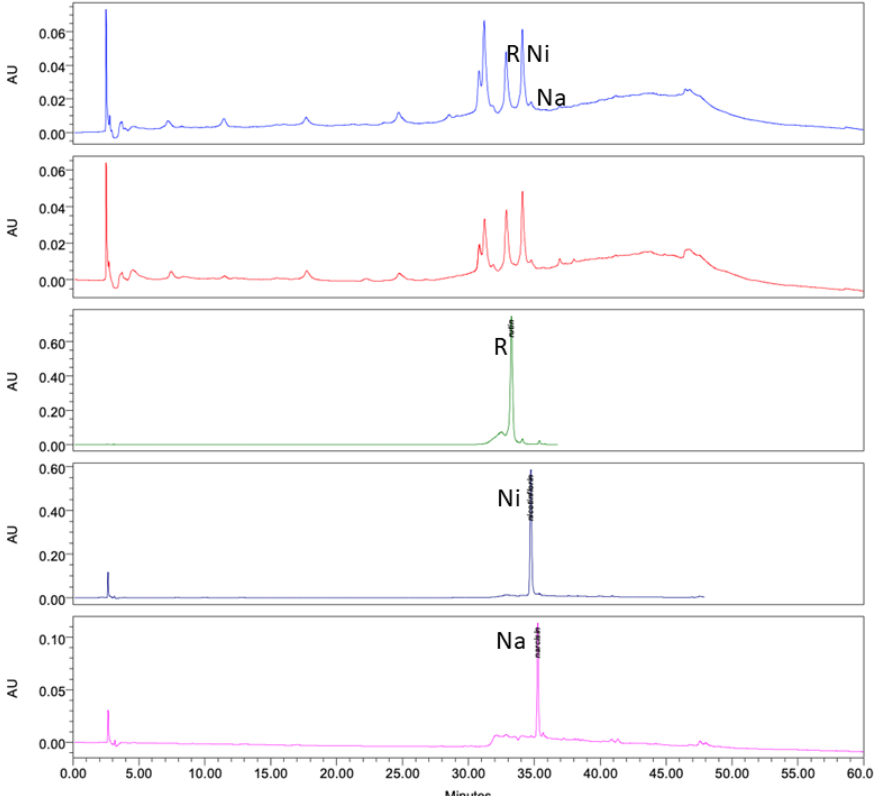
Figure 4. High-performance liquid chromatography with diode-array detection (HPLC-DAD) analysis at 254 nm of ethanol extract from A. muricata leaves . TeDe (blue) and AcDe (red); flavonol glycosides standards, rutin (R, green), nicotiflorin (Ni, gray), and narcissin (Na, magenta).